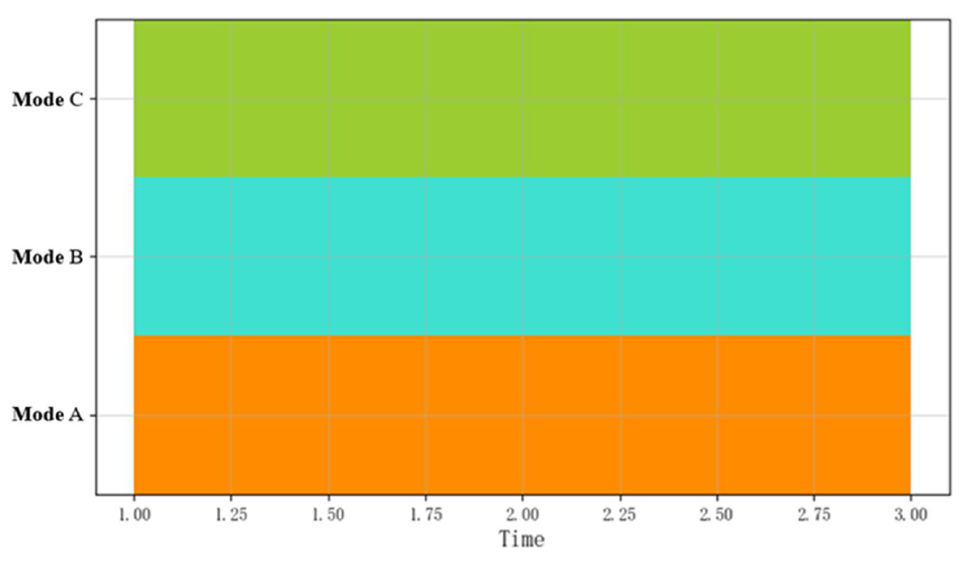
Figure 2. Visual representation of an event flow.